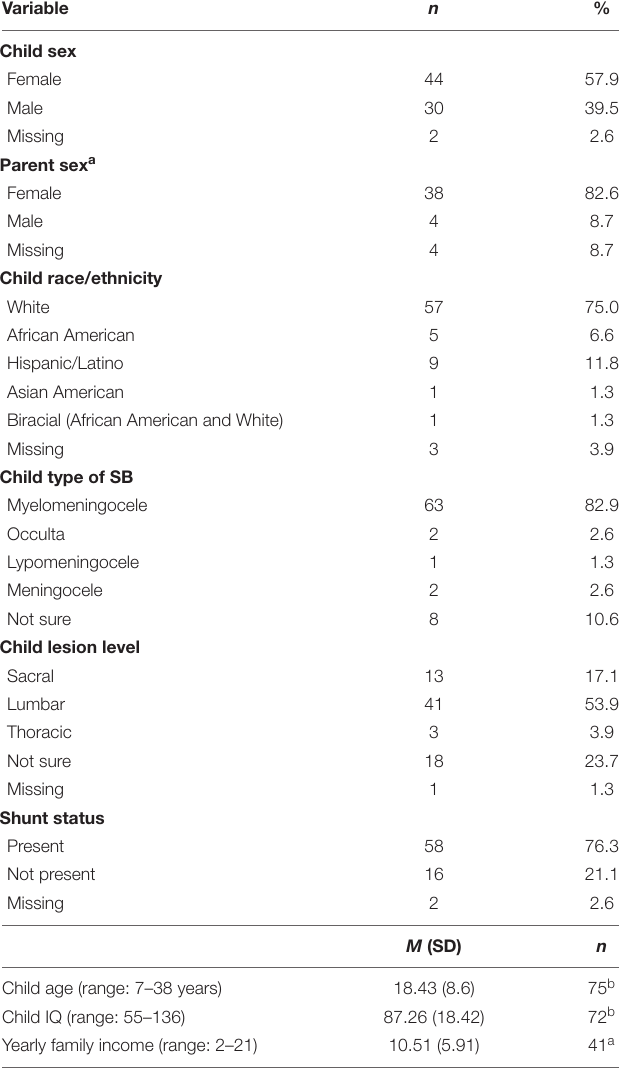
TABLE 1 | Descriptive demographic and medical information for sample, n =